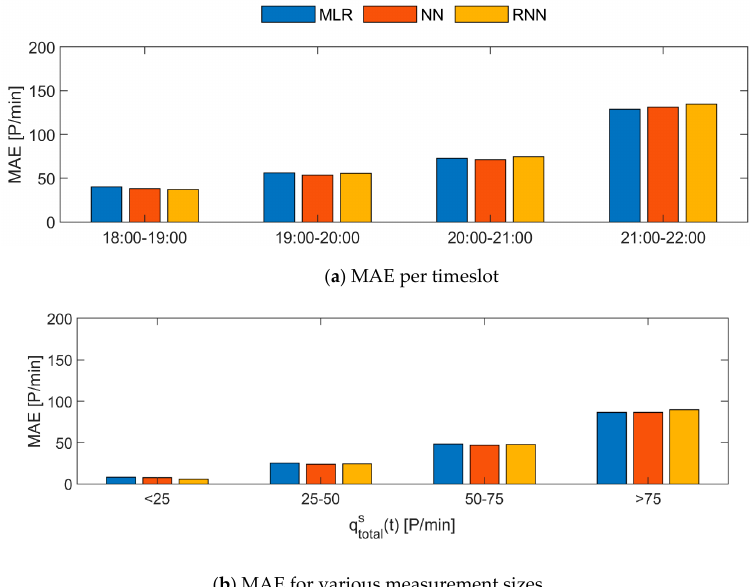
Figure 9. Bar graphs comparing the Mean Absolute Error (MAE) of the models’ results for the validation dataset for various timeslots ( a ) and sizes of the measurement ( b ).